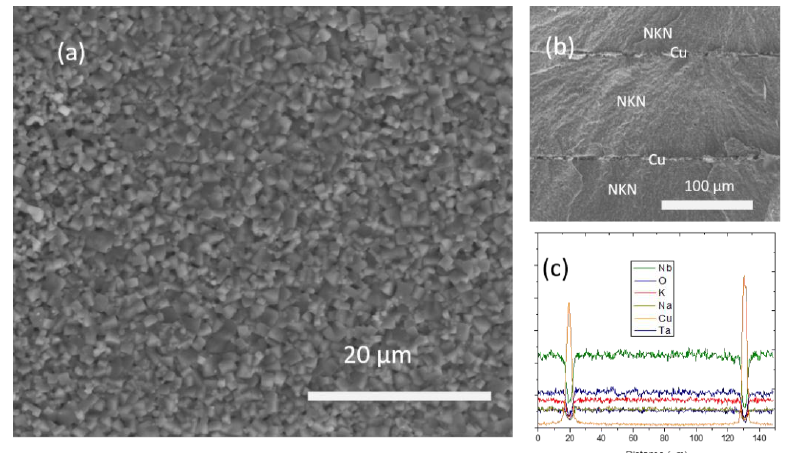
Figure 10. SEM Micrograph on ( a ) surface, ( b ) cross-section of Cu co-fired actuator, ( c ) EDS line scan on the cross-section of Cu co-fired actuator.